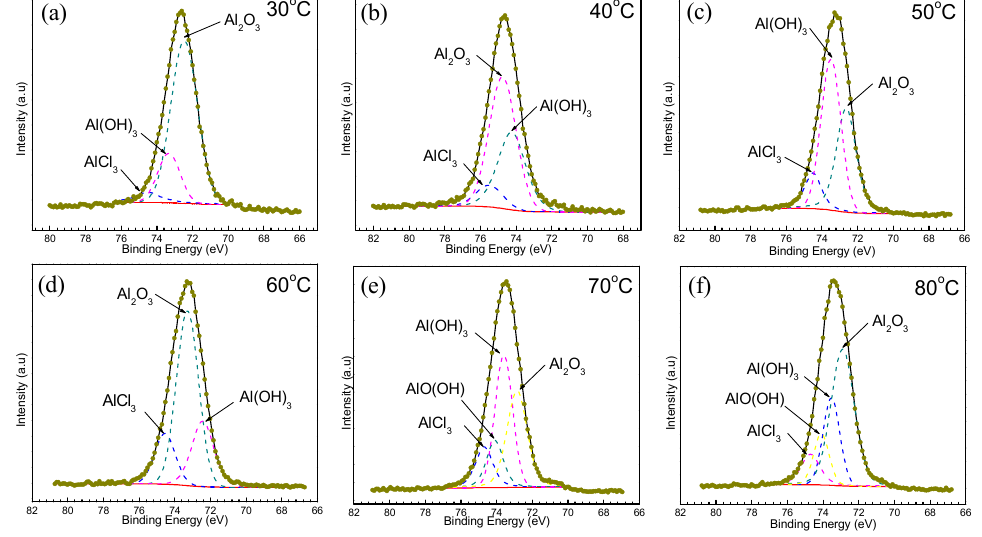
Figure 17. XPS result of 2A02 Al alloy prepared in the simulated marine atmospheric corrosion environment within 200 h at ( a ) 30; ( b ) 40; ( c ) 50; ( d ) 60; ( e ) 70; and ( f ) 80 °C. Table 1 The contents of each compound produced at different temperatures (at %).